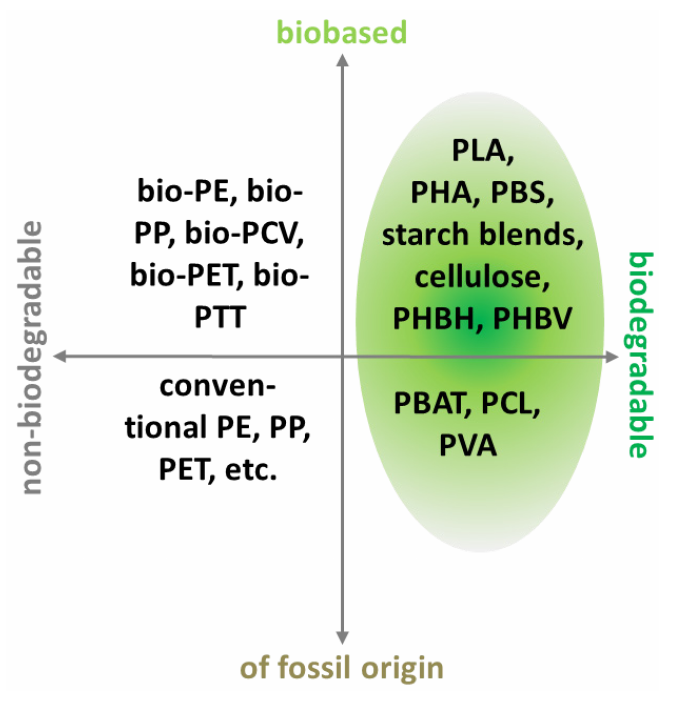
Figure 4. Schematic representation of the diversity of degradable